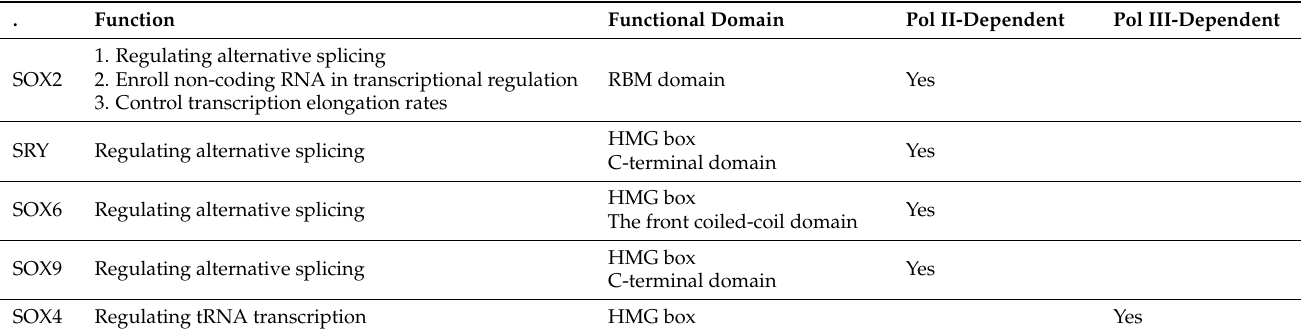
Table 1. Sox proteins and their functional